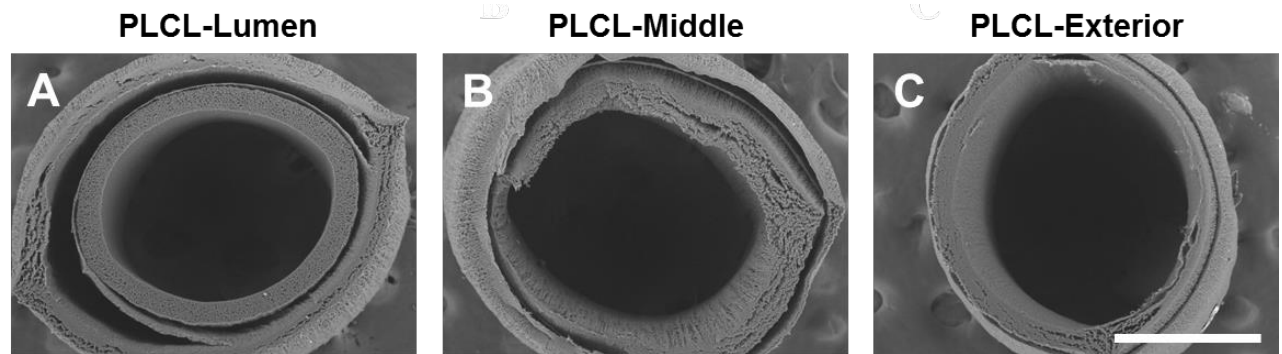
Figure 3. Characterization of multi-layered vascular grafts. Cross-section surfaces of multi-layered vascular grafts with the following structure: ( A ) PLCL as the luminal layer and PDO as the exterior layer; ( B ) PLCL as the middle layer and PDO as both the luminal and the exterior layer; and ( C ) PDO as the luminal layer and PLCL as the exterior layer. Scale bar = 500 μm.